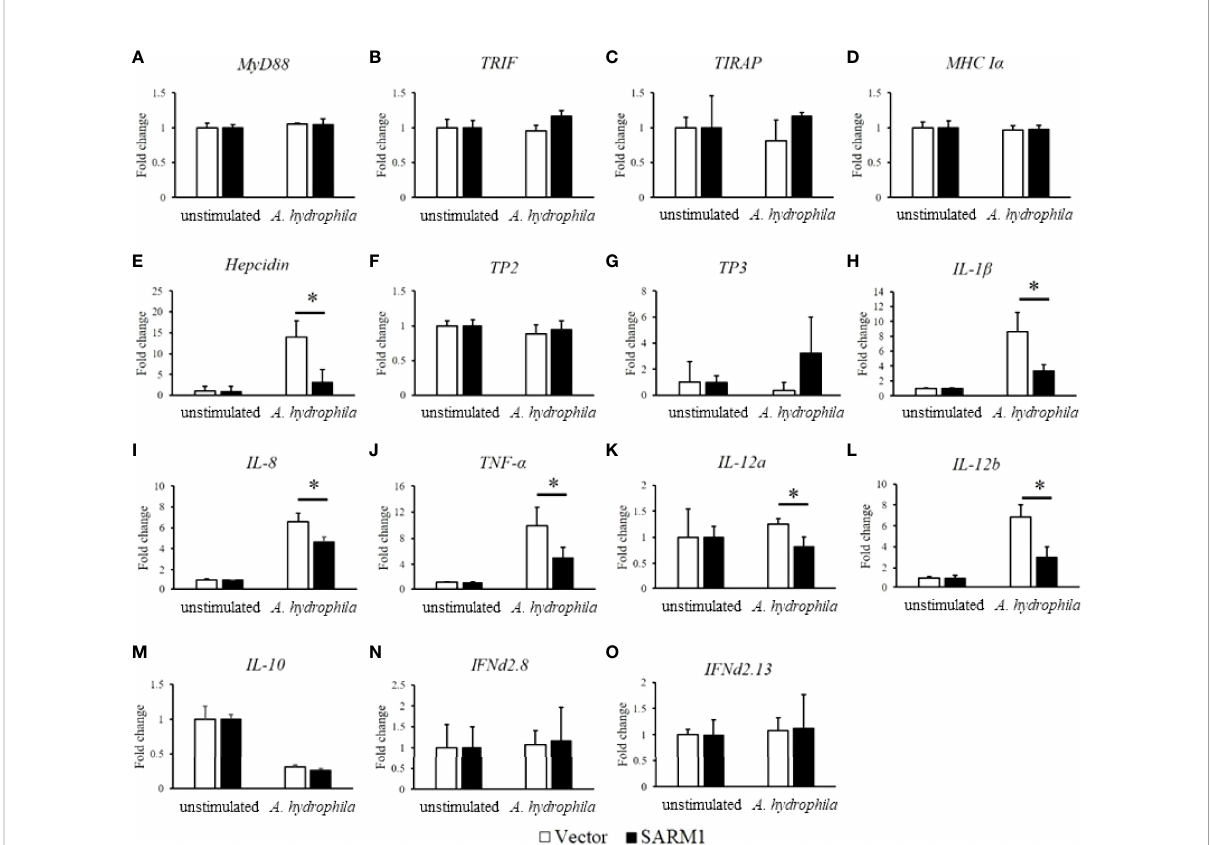
FIGURE 11 OnSARM1 inhibits mRNA expression of immune genes (A) MyD88 , (B) TRIF , (C) TIRAP , (D) MHC Ia, (E) Hepicidin , (F) TP2 , (G) TP3 , (H) IL-1b , (I) IL- 8 , (J) TNF-a , (K) IL-12a , (L) IL-12b , (M) IL-10 , (N) IFNd2.8 , (O) IFNd2.13 in Aeromonas hydrophila lysate stimulated THK cells. THK cells were transfected with empty vector or OnSARM1-3×FLAG expression plasmids. Forty-eight hours post transfection, the cells were treated with lysates from A. hydrophila (10 µg bacterial protein/ml culture medium) for 4 h; this was followed by gene expression analysis (n=3). The values are shown as mean + SD. Signi fi cant differences from the vector group are indicated by asterisks (P < 0.05, unpaired sample